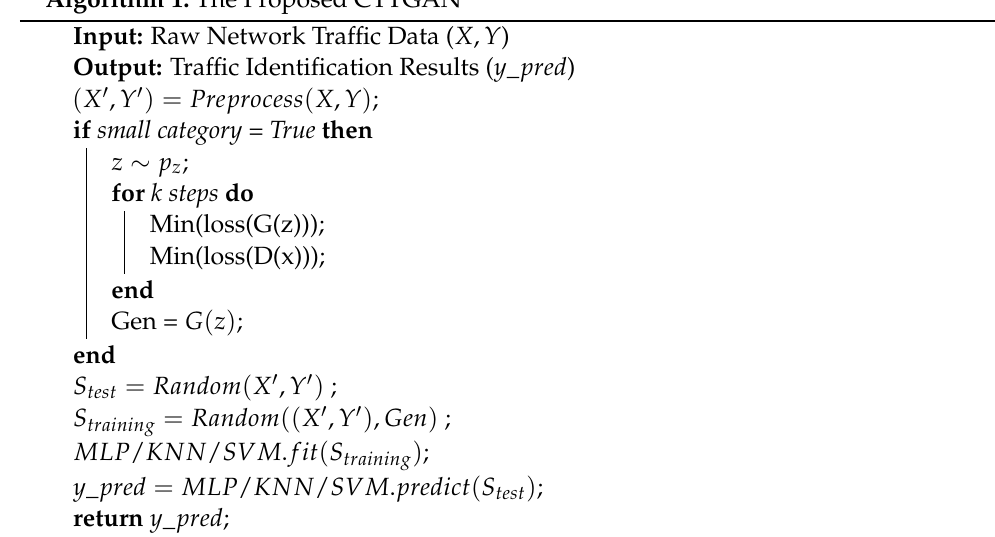
Algorithm 1: The Proposed CTTGAN